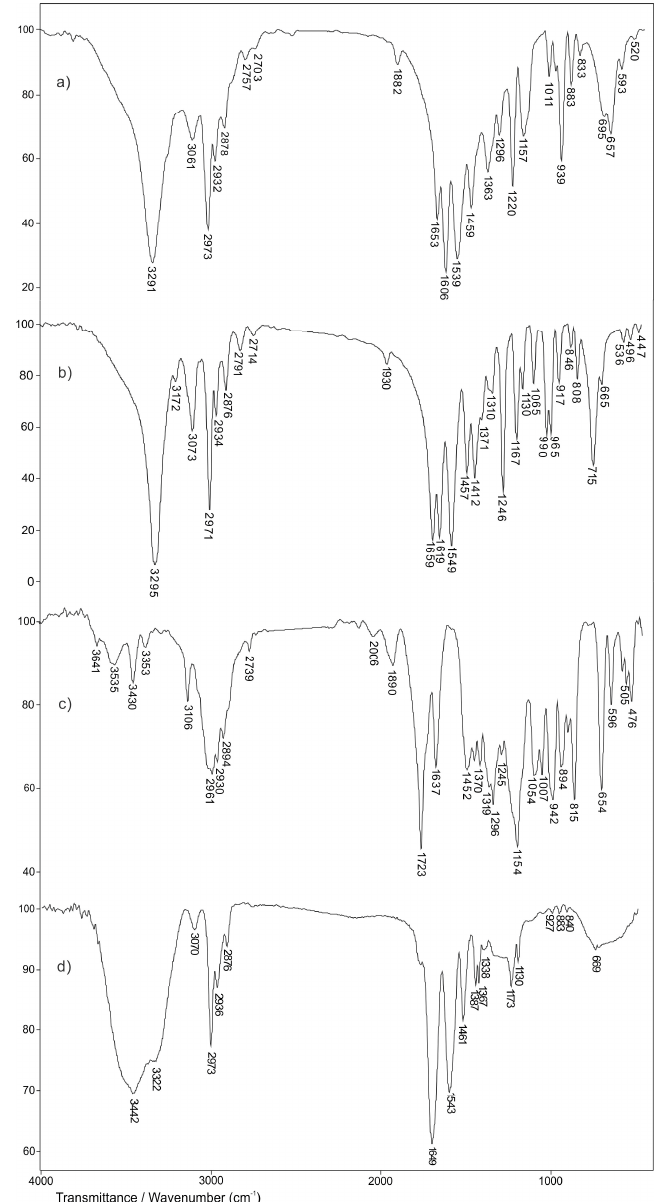
Figure 8. FTIR spectra: ( a ) NiPMAm monomer, ( b ) NiPAm monomer, ( c ) crosslinker EGDM and ( d ) synthesized p(NiPMAm/NiPAm) copolymer with 2 mol% of EGDM. In the FTIR spectrum of NiPMAm monomer (Figure 8a), the absorption band 3291 cm − 1 is a result of valence N ‐ H vibrations, ν (N ‐ H). Asymmetric valence vibrations of C ‐ H bond of the vinyl group, ν as(= C ‐ H), give an absorption band with a maximum at 3061 cm ‐ 1 . The absorption bands at 2973 and 2878 cm ‐ 1 are from asymmetric and symmetric valence of the methyl group in the NiPMAm monomer structure, respectively. The proof for the presence of the amide group in the monomer structure are absorption bands with